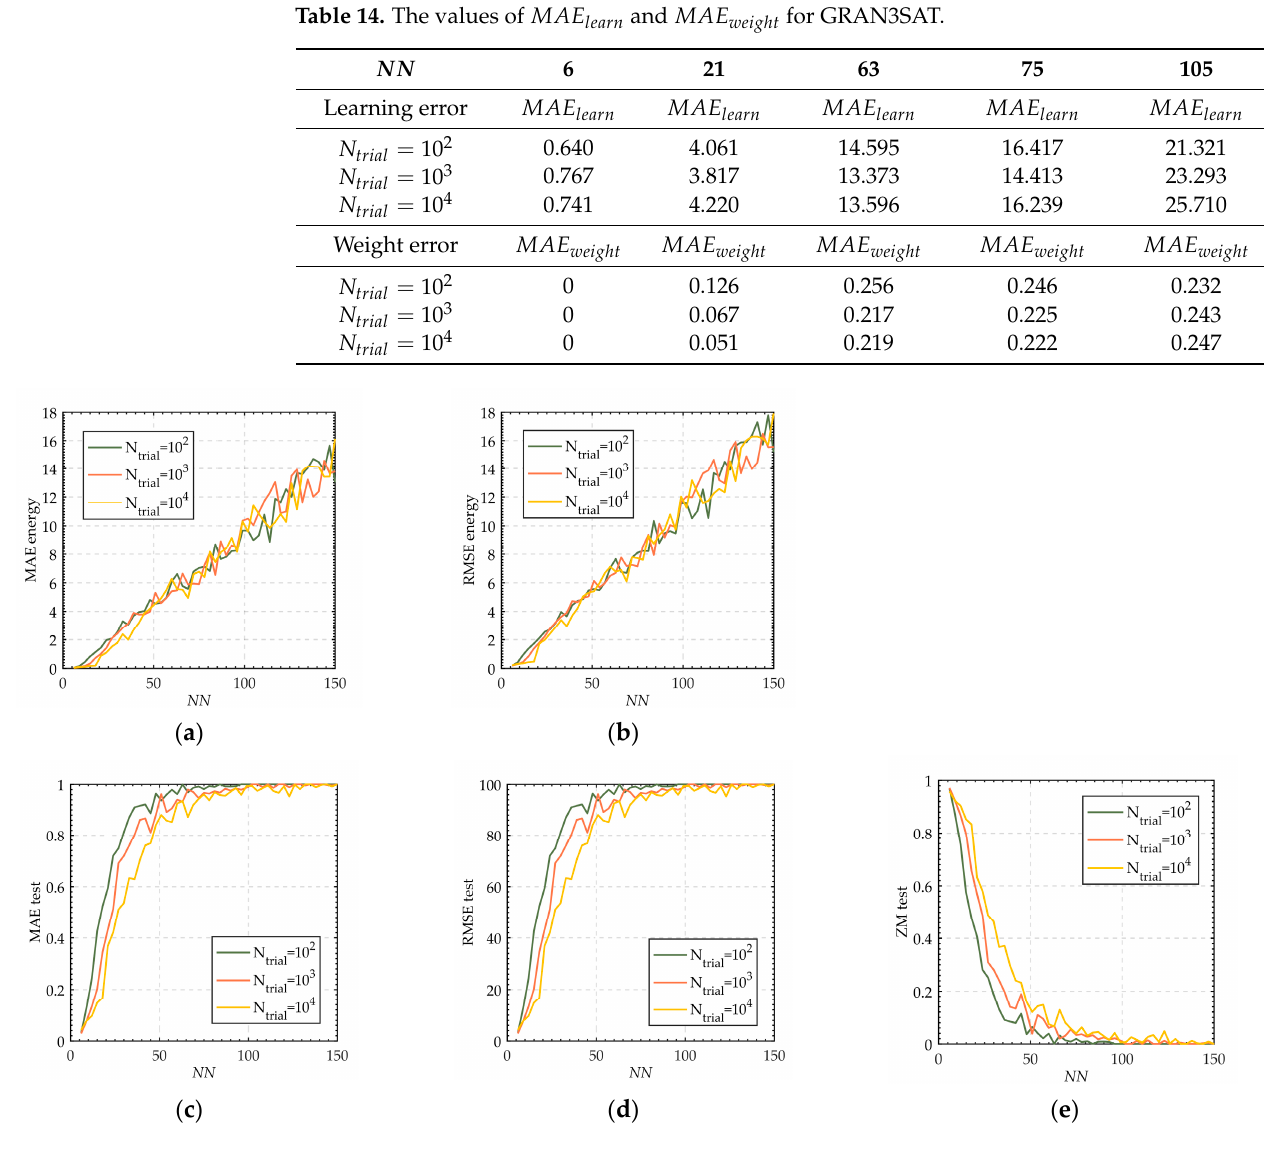
Figure 10. Error performance for ( a ) MAE energy , ( b ) RMSE energy , ( c ) MAE test , ( d ) RMSE test , and ( e ) ZM test . Table 15. The slope of the linear fitting for MAE energy . N